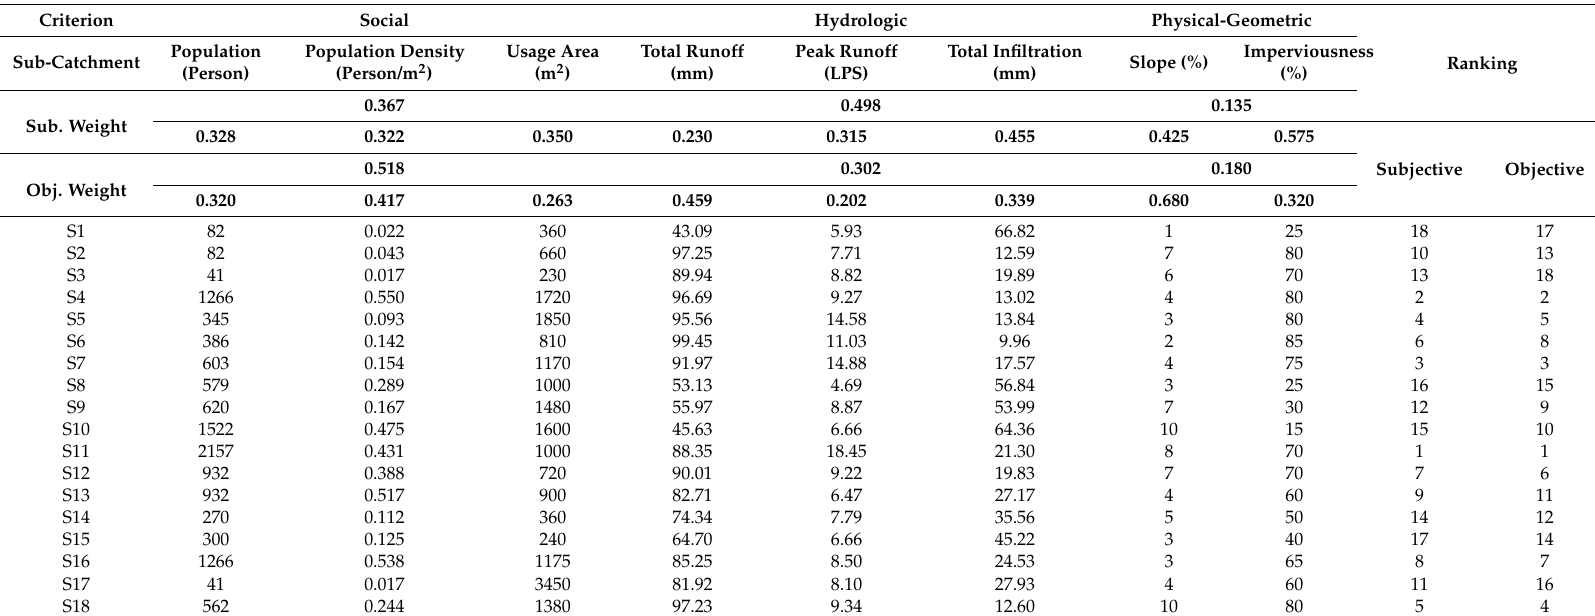
Table 4. Data used and derived ranks using TOPSIS for the selection of sub-catchments to the 5th step of Water Management Prioritization Module (WMPM). Criterion